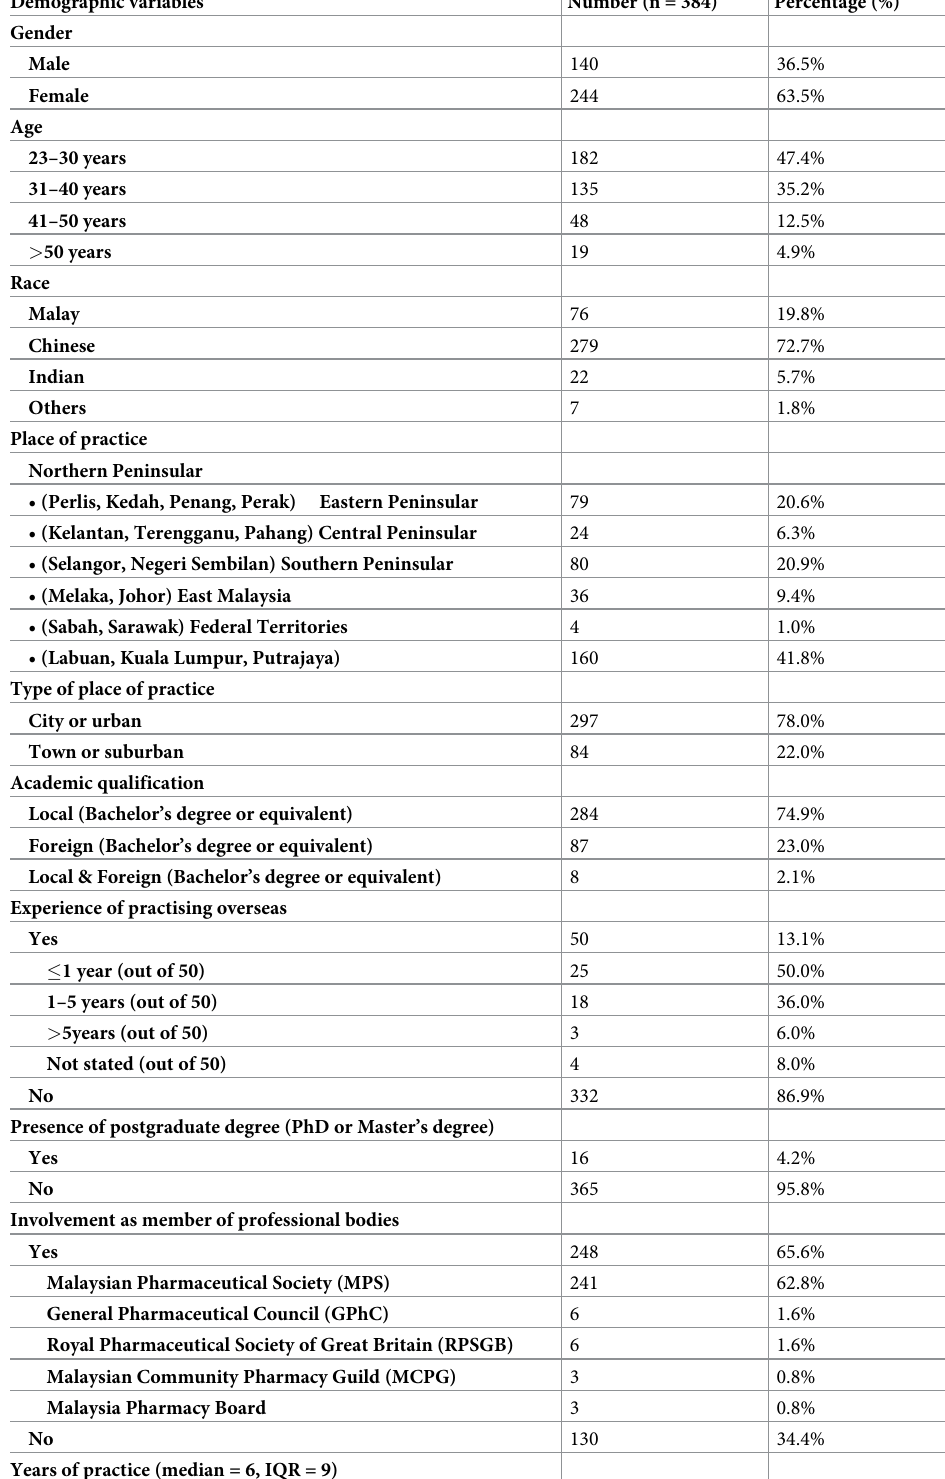
Table 1. The respondents’ demographic characteristics (n =